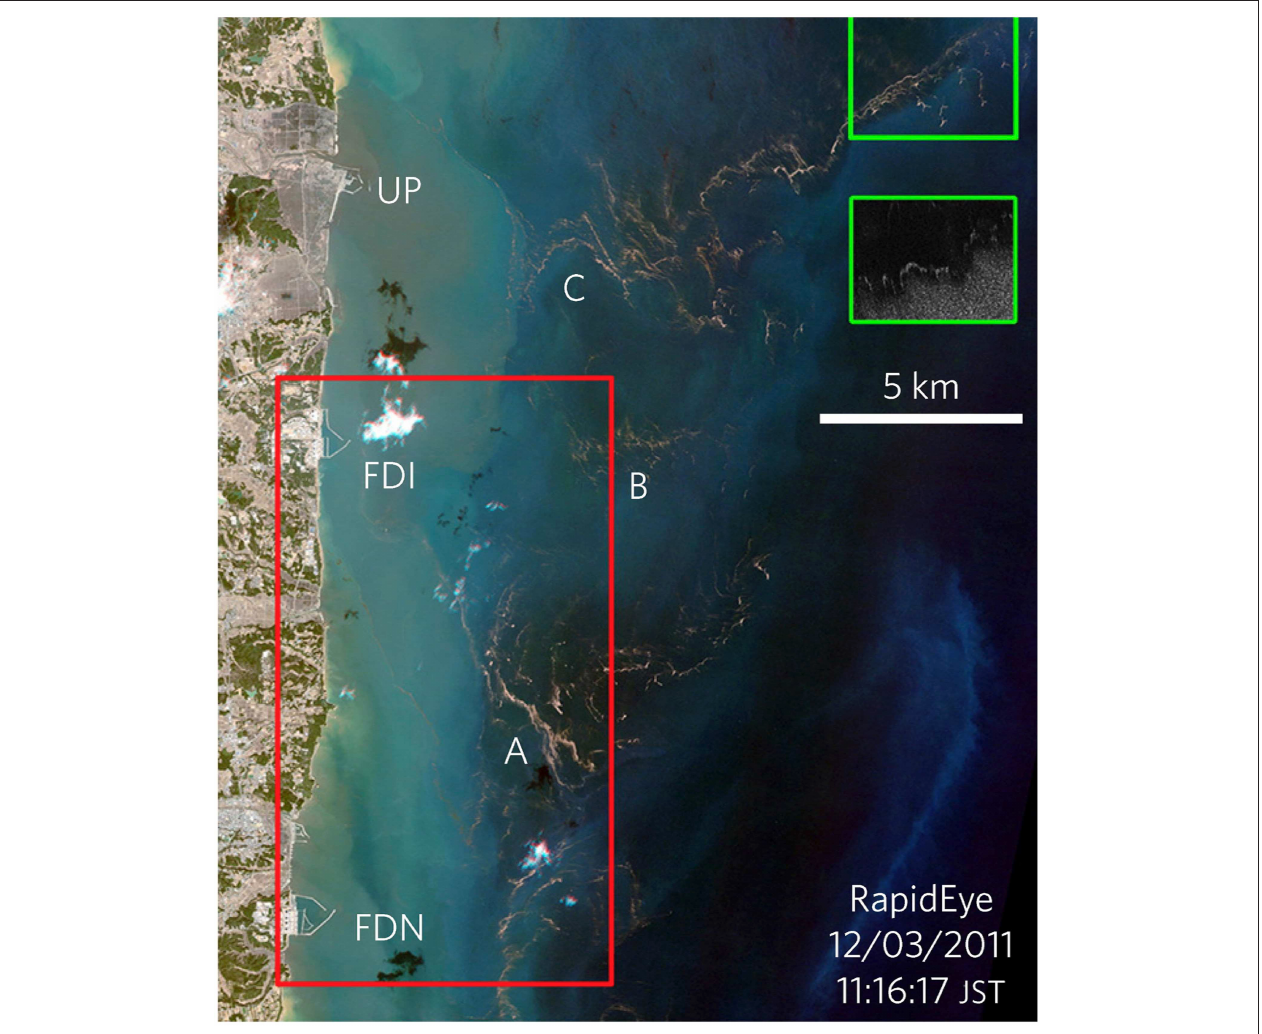
FIGURE 7 | RapidEye image of debris, floating east of Japan 1 day after the March 11, 2011 tsunami showing Ukedo Port (Port), Fukushima Daiichi (FDI) nuclear power station and Fukushima Daini (FDN), floating litter A–C visible on 12 March 2011 [Adopted from (Matthews et al., 2017)] (Maximenko has permission from Nature Geosciences to use this